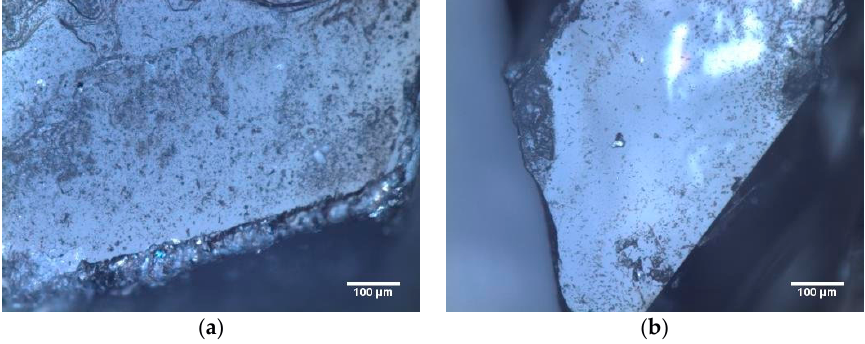
Figure 6. Optical micrographs of ( a ) an HMX crystal ( b ) and an idoxuridine crystal.